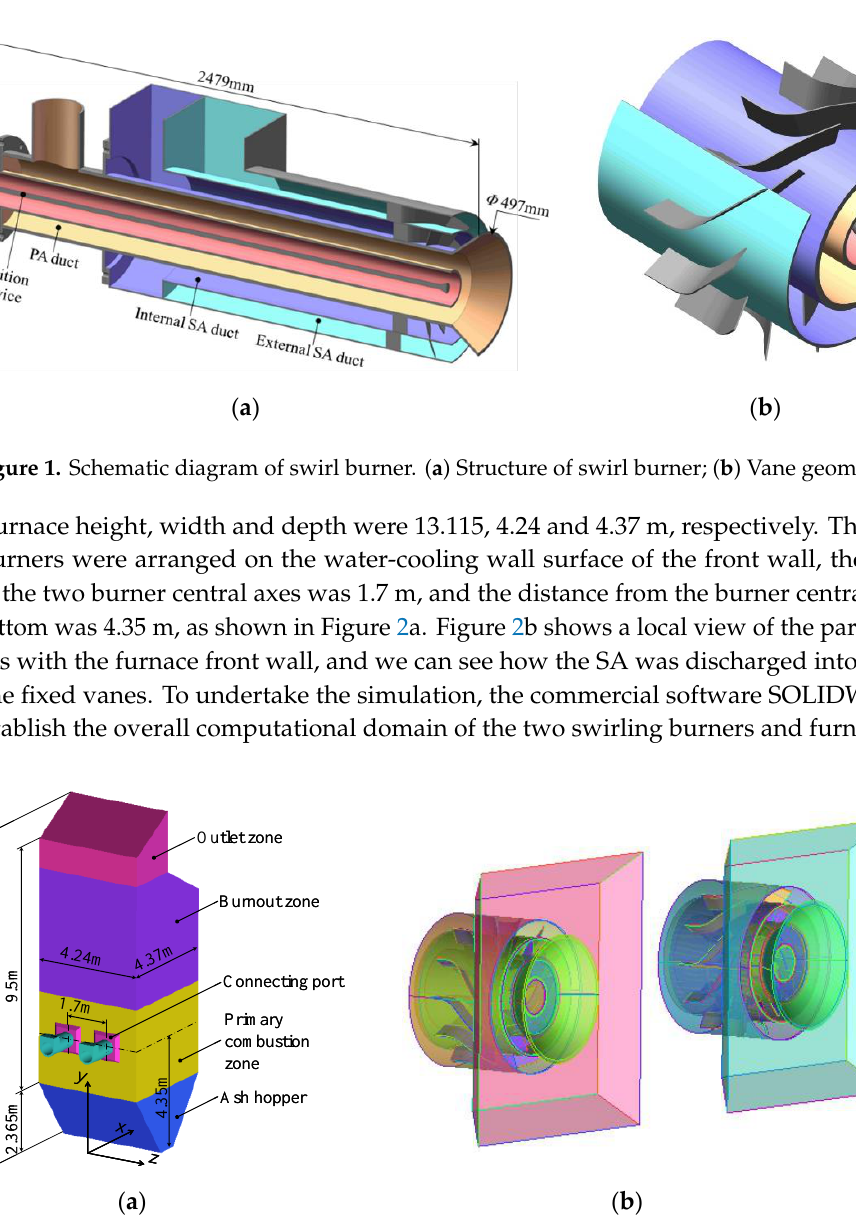
Figure 2. Computational domain. ( a ) Computational domain; ( b ) Local view of the part connecting the burners with the furnace front wall.